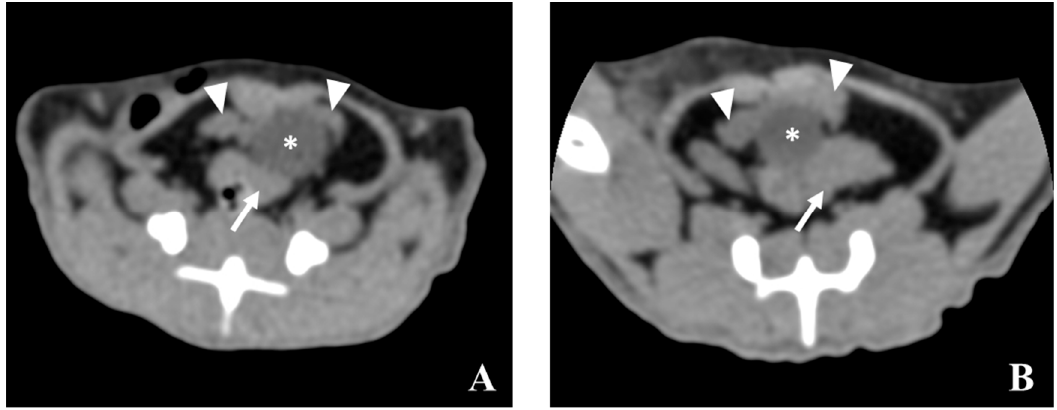
Figure 7. CT soft tissue window (WW 400, WL 40) transverse plane of prostate from control ( A ) and from cancer-induced ( B ) animals at 60 weeks of age without contrast. An enlargement of prostate and seminal vesicles from the cancer-induced animal is evident in the image ( B ). The urinary bladder (asterisk) is surrounded by the ventral prostate (arrowheads) and the seminal vesicles (arrow).